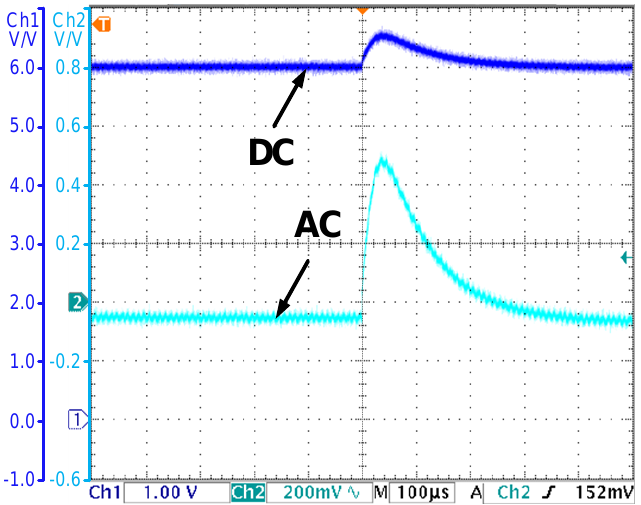
Figure 10. The output voltage transient when the load steps from 3 to 5 Ω—a conventional voltage mode controlled converter.